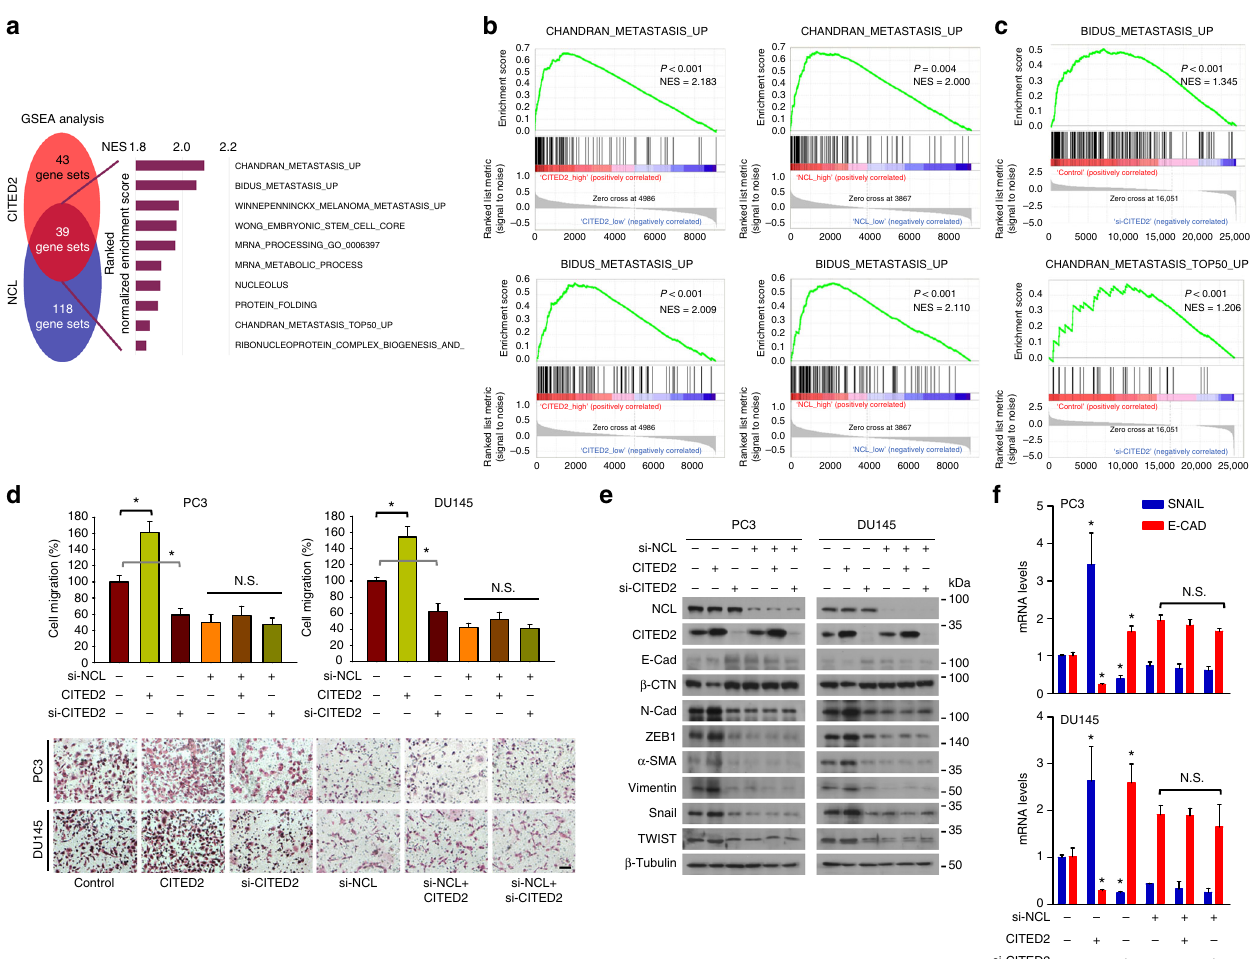
Fig. 5 CITED2 enhances metastatic potential NCL-dependently in prostate cancer. a Gene Set Enrichment Analysis (GSEA). Venn diagram depicts 39 gene sets upregulated ( P < 0.05 and FDR < 0.30) commonly by CITED2 and NCL expression. Of them, top 10 gene sets are listed. b Representative enrichment plots of the metastasis-related gene set which positively correlate with CITED2 (left panel) or NCL (right panel). c PC3 cells were transfected with control or CITED2-targeting siRNA. Total RNAs were extracted using Trizol and subjected to RNA-sequencing analyses. The experiments were performed three times independently. The graphs show representative enrichment plots of the metastasis-related gene set which positively correlate with CITED2 in PC3 cell. d Cell migration was analyzed using a transwell chamber. PC3 and DU145 cells (1 × 10 4 /well), which had been transfected as indicated, were placed on the upper chamber. After 12 h, cells passing through the interface membrane were stained (bottom) and counted (top). Each bar represents the mean + SD ( n = 3). The scale bar represents 25 μ m. e PC3 and DU145 cells were transfected with CITED2 or si-CITED2, and/or si-NCL. Representative EMT markers were immunoblotted. f RNAs were extracted from PC3 or DU145 cells which were transfected with CITED2 or si-CITED2 and/or si-NCL. The SNAIL and E- CAD mRNA levels were measured by RT-qPCR. Each bar represents the mean + SD ( n = 3). * P < 0.05 versus the control group; N.S. not signi fi cantly different ’ among the groups by Student ’ s t